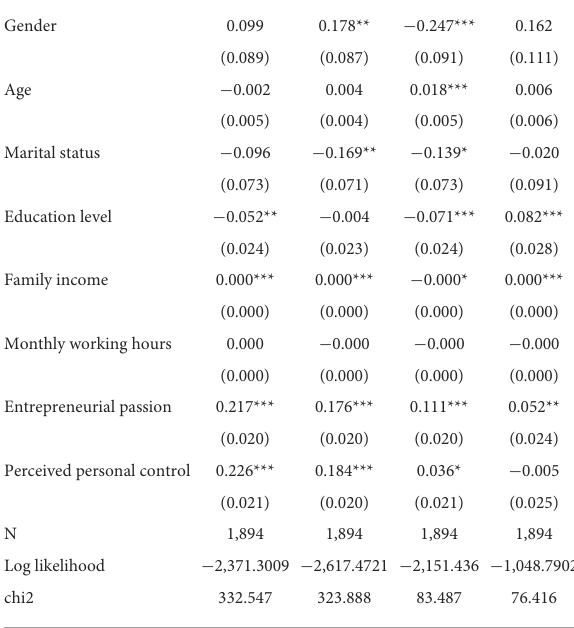
TABLE 2 The spillover test of entrepreneurial passion with life satisfaction, economic satisfaction, neighbor trust, and donation